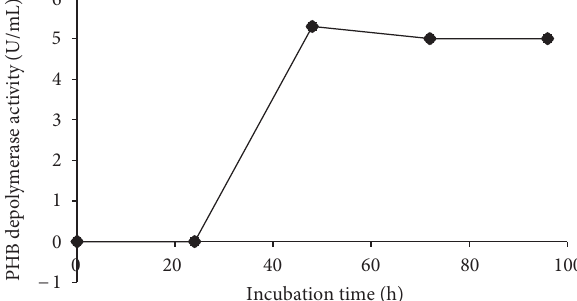
F 3: Time course production of PHB depolymerase by F. solani